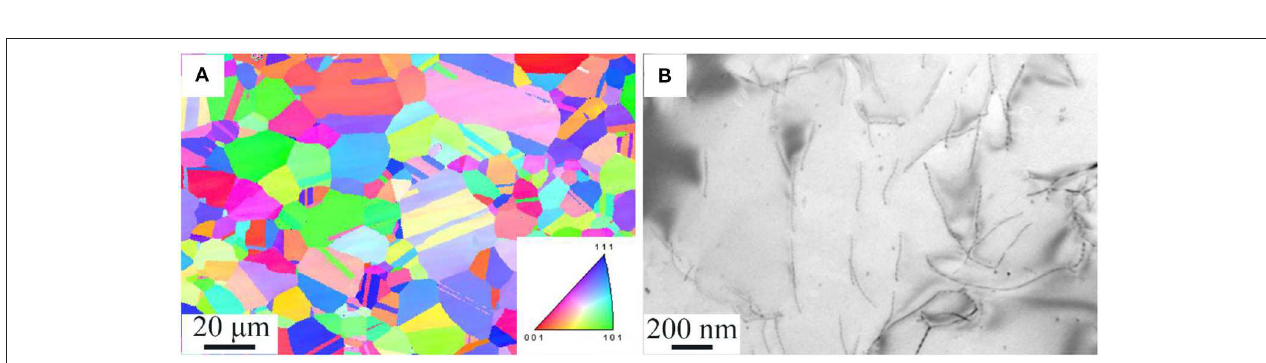
FIGURE 4 | Microstructure of the cold rolled sample to 95%, followed by subsequent annealing at 900 ◦ C for 1h. (A) IPF image and (B) TEM image.